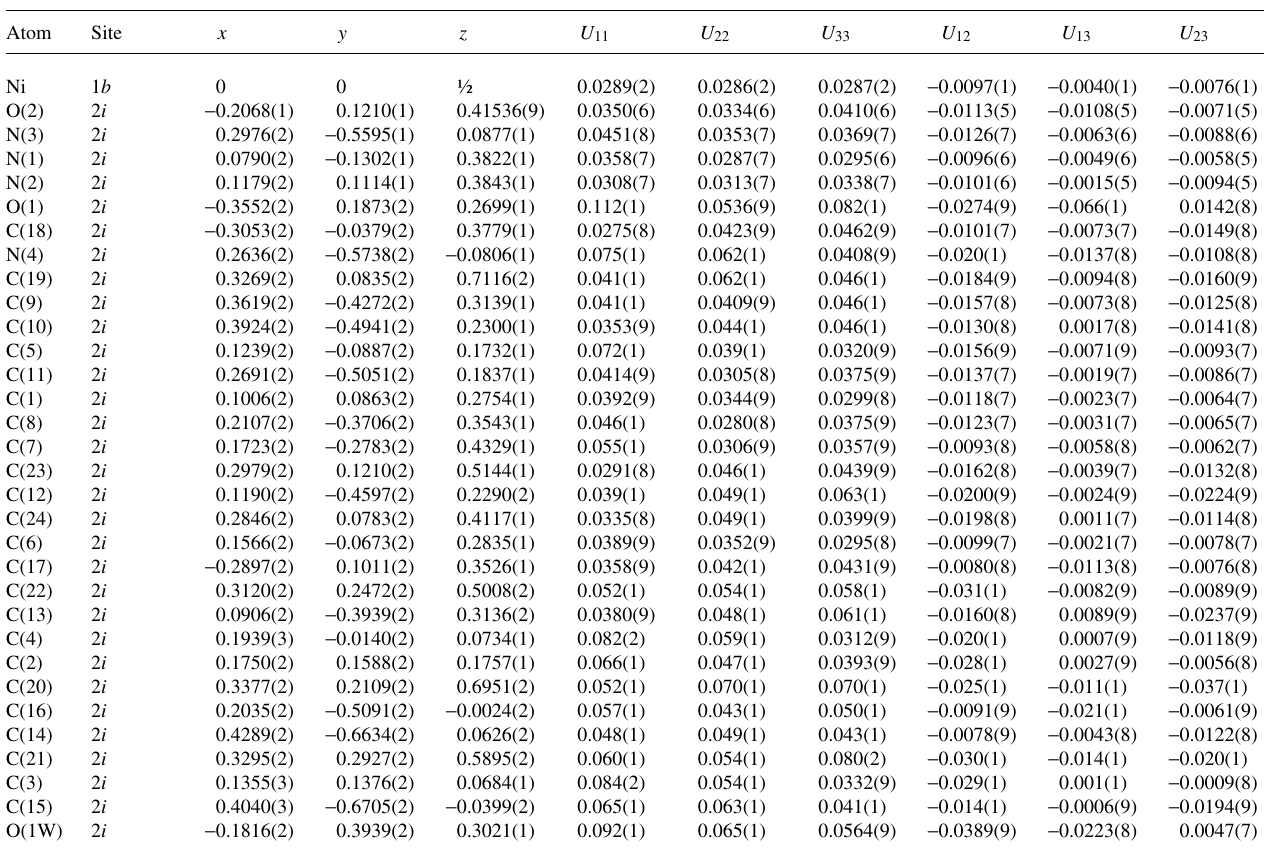
Table 3. Atomic coordinates and displacement parameters (in Å 2 ) .